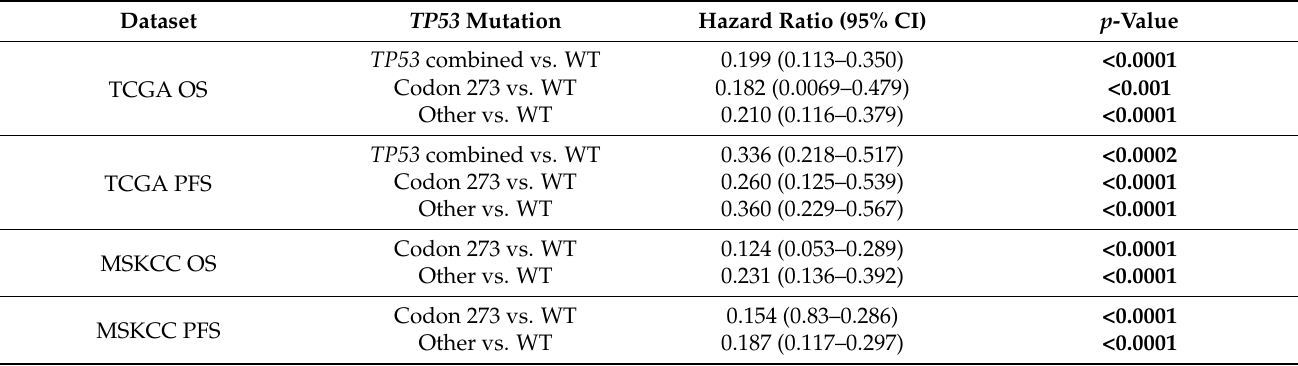
Table 5. Univariate survival analysis of TCGA and MSKCC